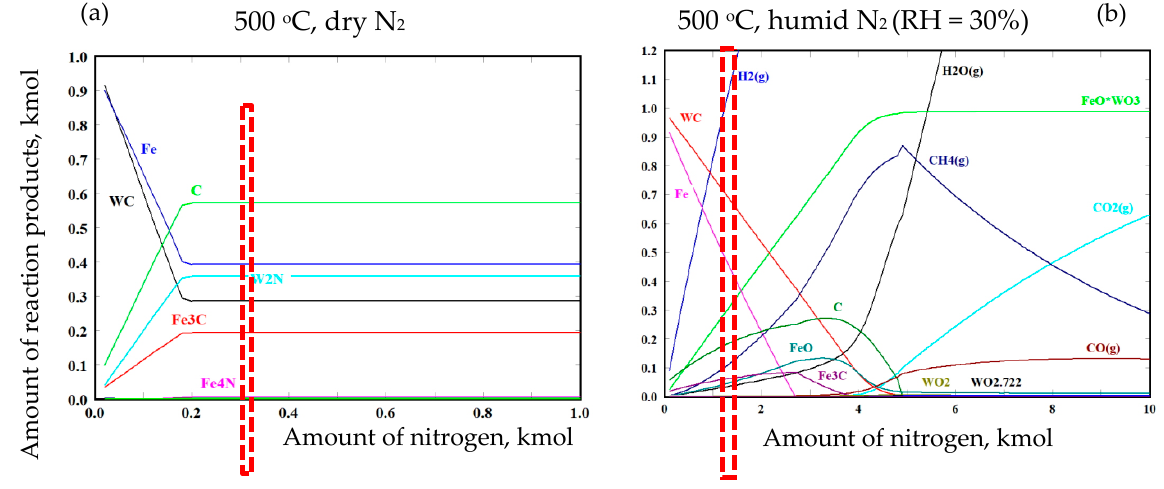
Figure 20. Analogous modeling of the reaction products in WC + 5% C + Fe system at 500 °C in ( a )—dry nitrogen (reprinted with permission from Ref. [27], 2022, Elsevier) and ( b ) humid (RH = 30%) nitrogen. Vertical frame indicates the amount of nitrogen when the compositions similar as in the experiment can be obtained.